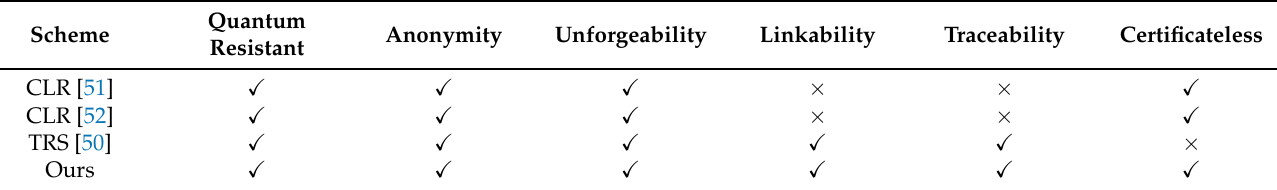
Table 2. Functional comparison of lattice-based ring